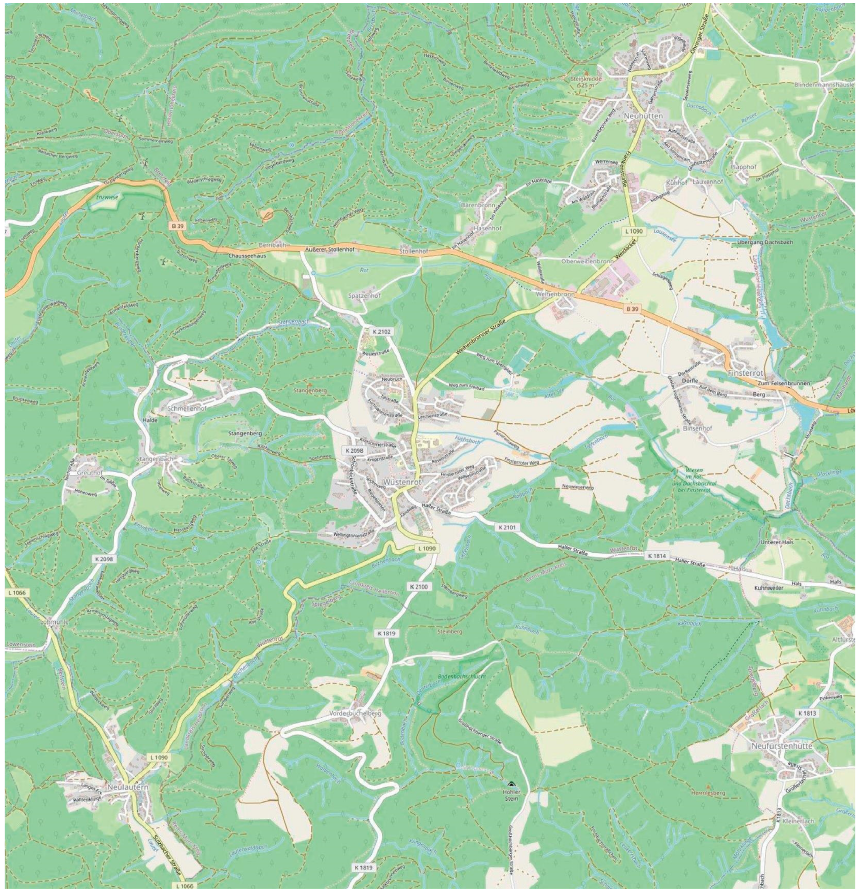
Figure 3: Map of the study area W¨ustenrot [24], © openstreetmap-contributors. Table 1: Items used in the